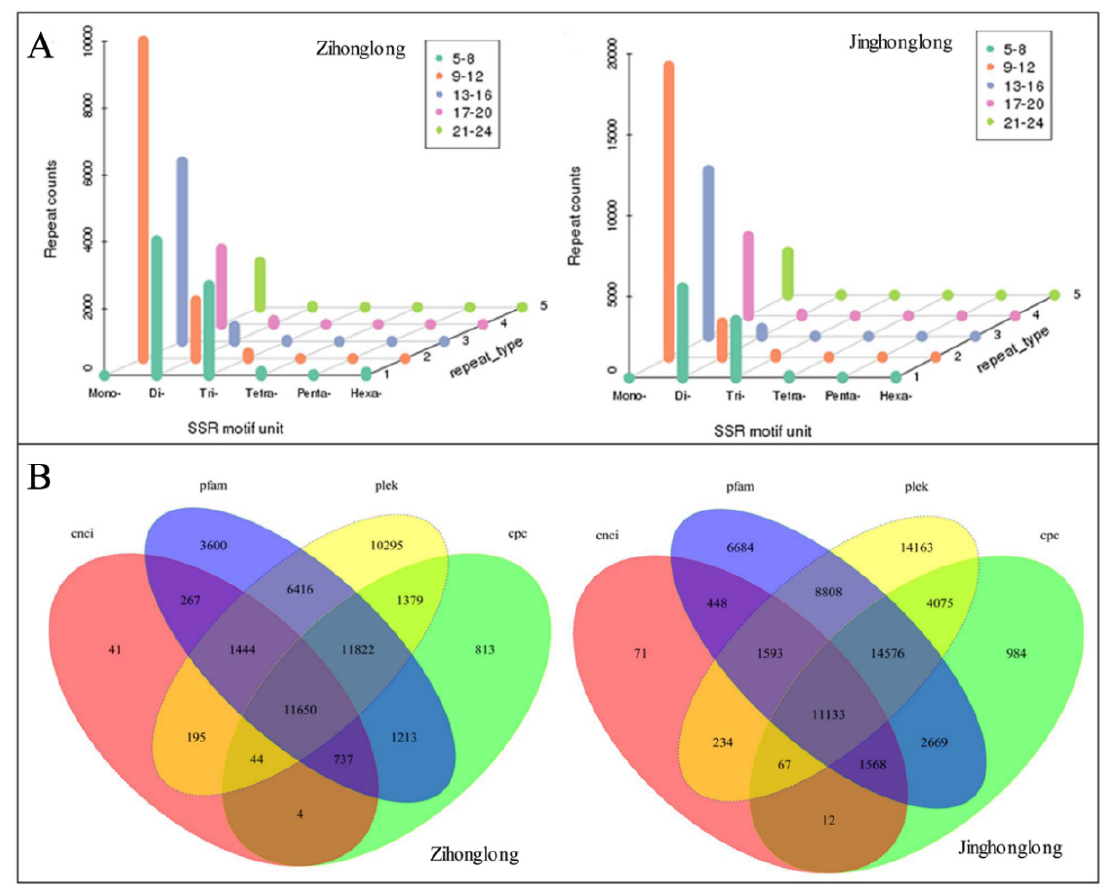
Figure 3. SSRs and lncRNAs of pitaya pulp. ( A ), The distribution characteristics of SSRs motifs. ( B ), Venn diagram of the number of lncRNAs predicted by Coding-Non-Coding Index (CNCI), pfam, Plek, and Coding Potential Calculator (CPC). Note, the number in Figure 3B represents the amount of lncRNAs.